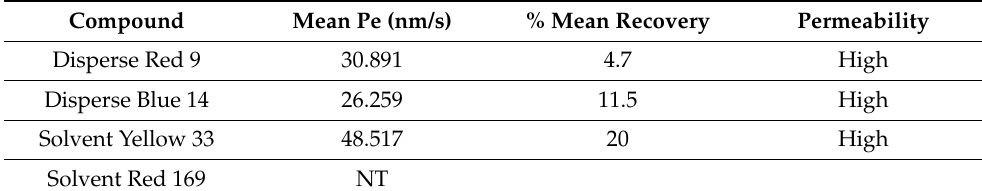
Table 3. Blood–brain barrierpermeability assay results. Pe is permeability. Low permeability: Pe < 1